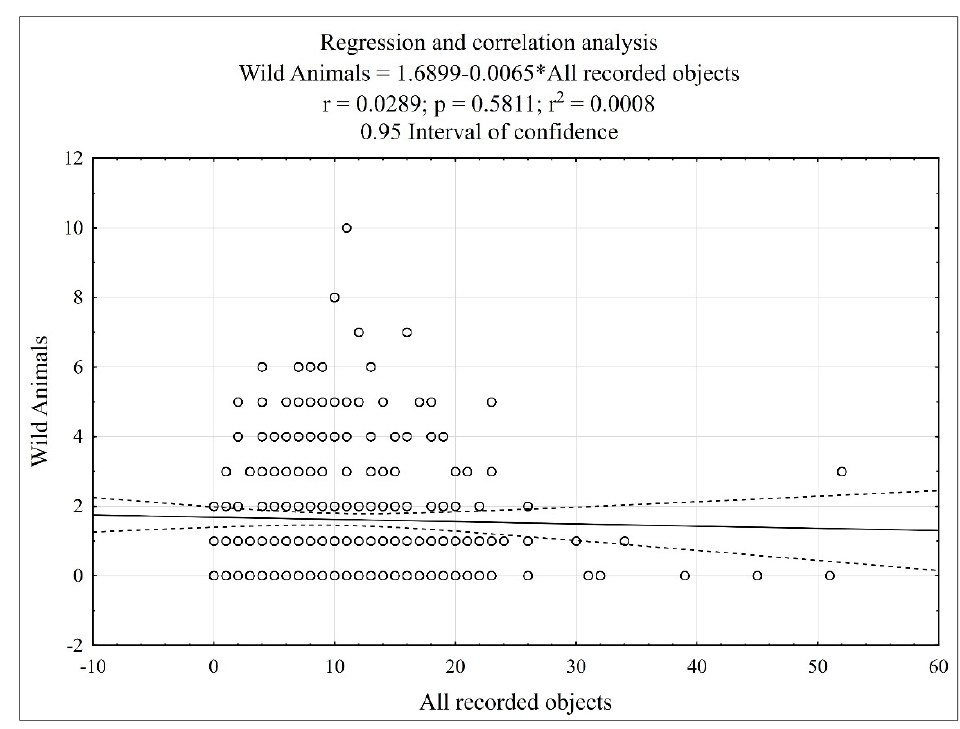
Figure 5. Regression and correlation analysis between daily frequencies of wild animals and all other objects recorded on the roads except animals (* in a figure caption is a multiplication sign).